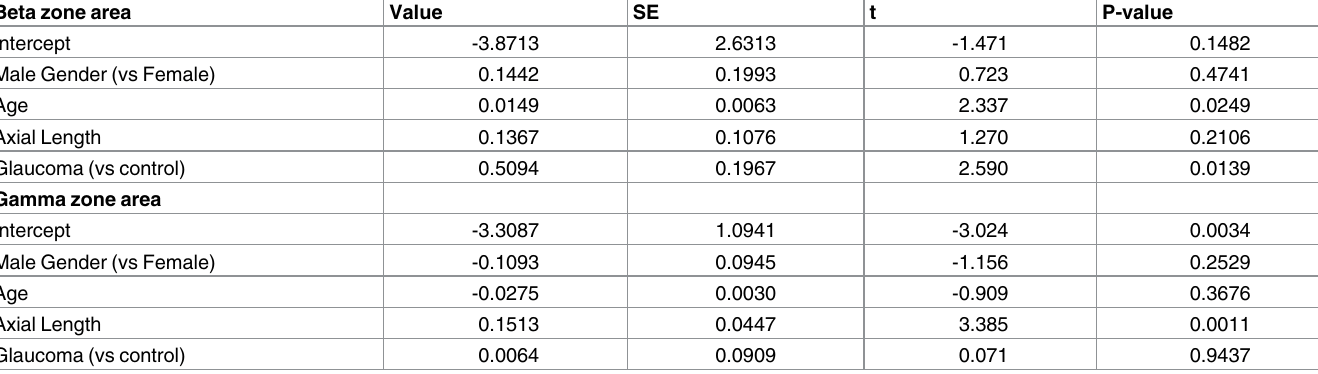
Fig 3. Scatterplots showing the correlation between axial length and A) the beta and B) the gamma zone parapapillary atrophy area. https://doi.org/10.1371/journal.pone.0175347.g003 Table 3. Multivariate regression analysesbetween patient characteristics and the beta zone and the gamma zone PPA area.